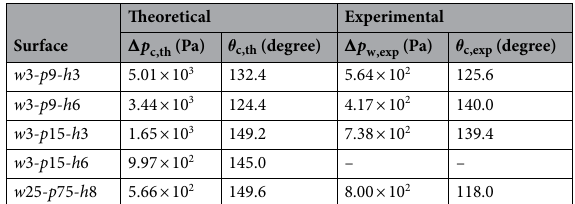
Table 1. Comparison of critical parameters during the